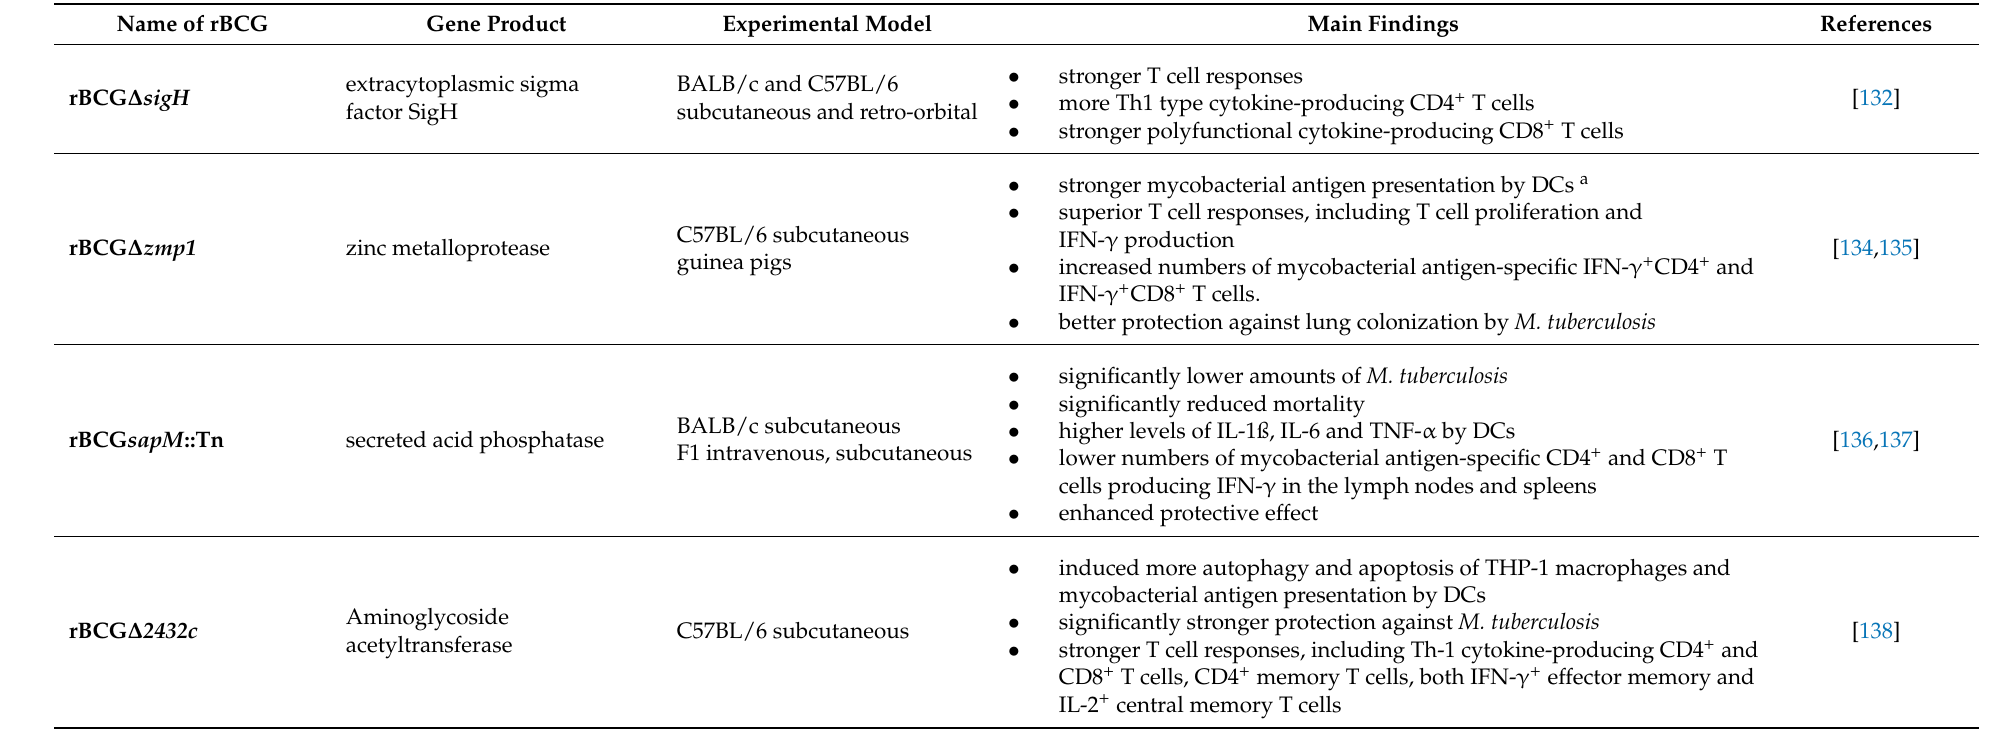
Table 3. rBCG with chromosomal